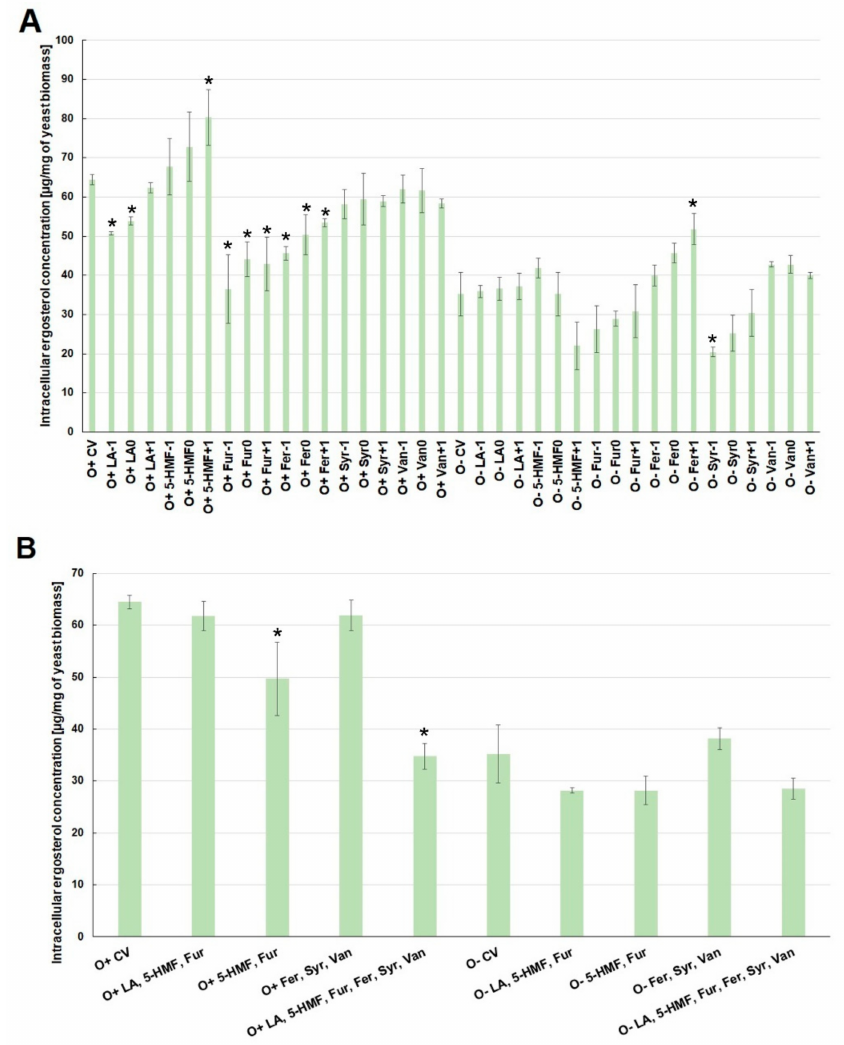
Figure 4. Effect of lignocellulose pretreatment by-products ( A , B ) on the production of intracellular ergosterol by yeast (*—statistically different from the corresponding control variant α <